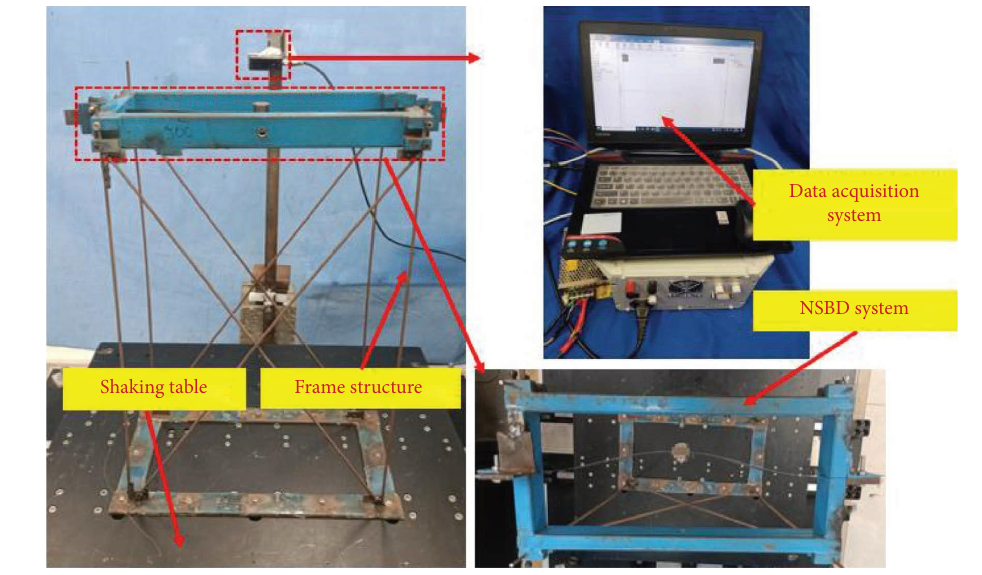
Figure 6: Experimental device. Table 1: Experimental parameters.